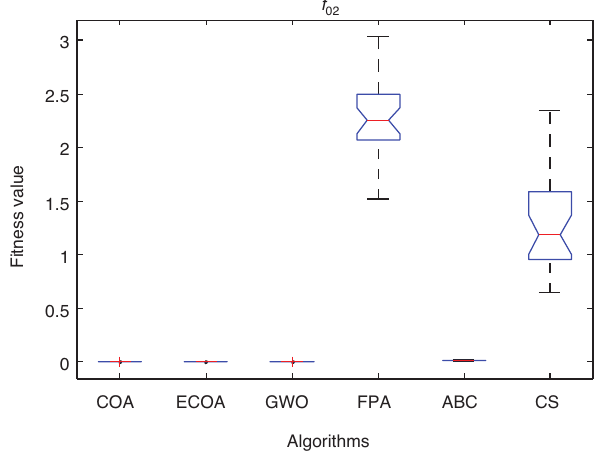
Figure 4: D = 30, ANOVA Test of Global Minimum for f